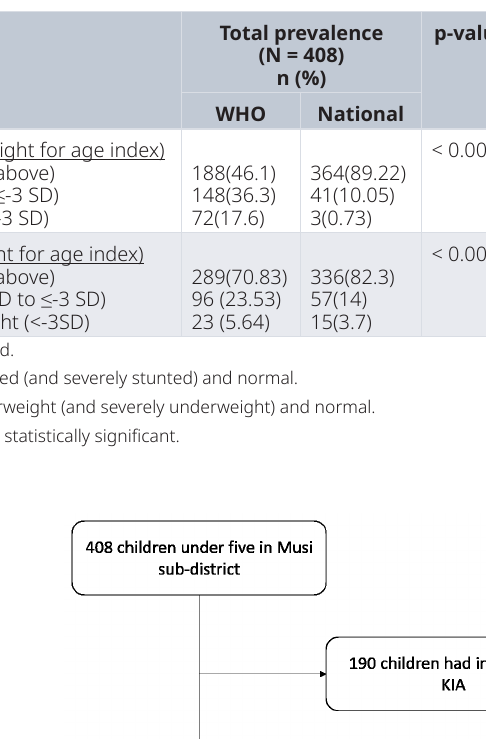
Table 1. Prevalence of stunting and underweight of children aged 0 – 59 months in Musi sub-district.